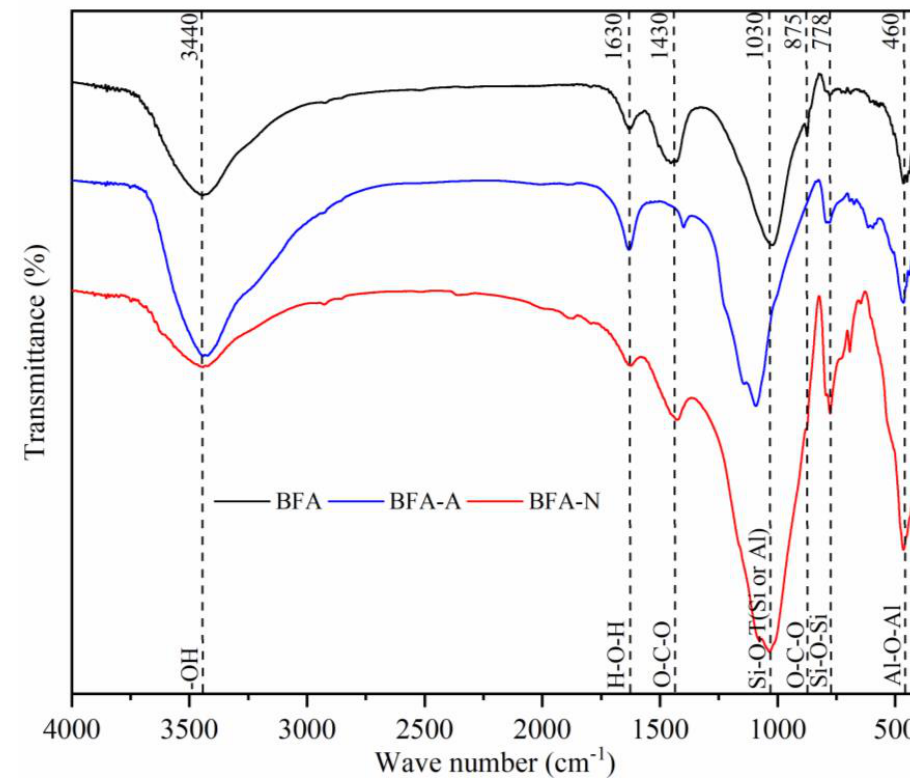
Figure 2. Functional groups of BFA, BFA-N, and BFA-A.